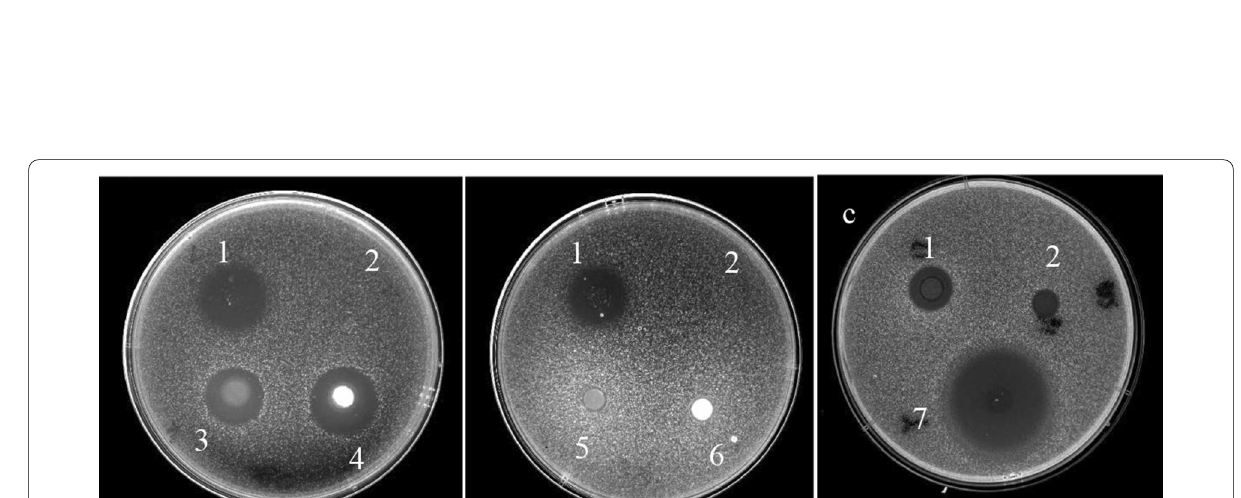
Fig. 2 The antibacterial activity of different fractions against Candida albicans with Oxford Cup method a The 3 rd and the 4th fractions had anti- Candida albicans activity, b while the 5th and the 6th did not, c The 10th fraction had stronger antibacterial activity. 1: Positive drug: Amphotericin B, 32 μg/mL; 2: Blank control: methanol solution; 3–7: Methanol solutions with different fractions, 5